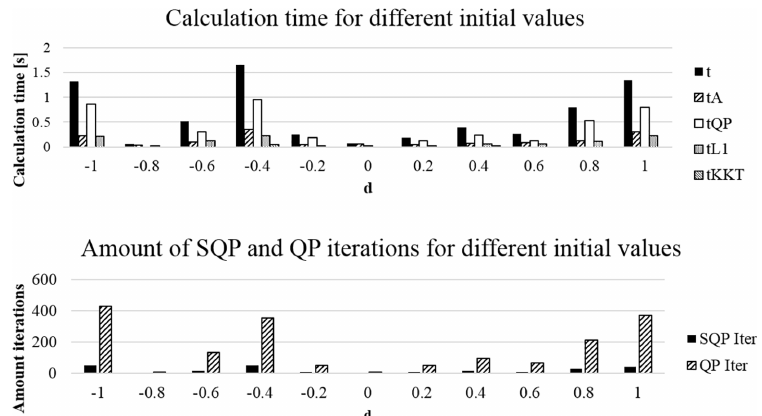
Figure 8. Effect of a variation of the initial value for the flange hole-pattern fit on the calculated SQP solution and its performance with DS1.